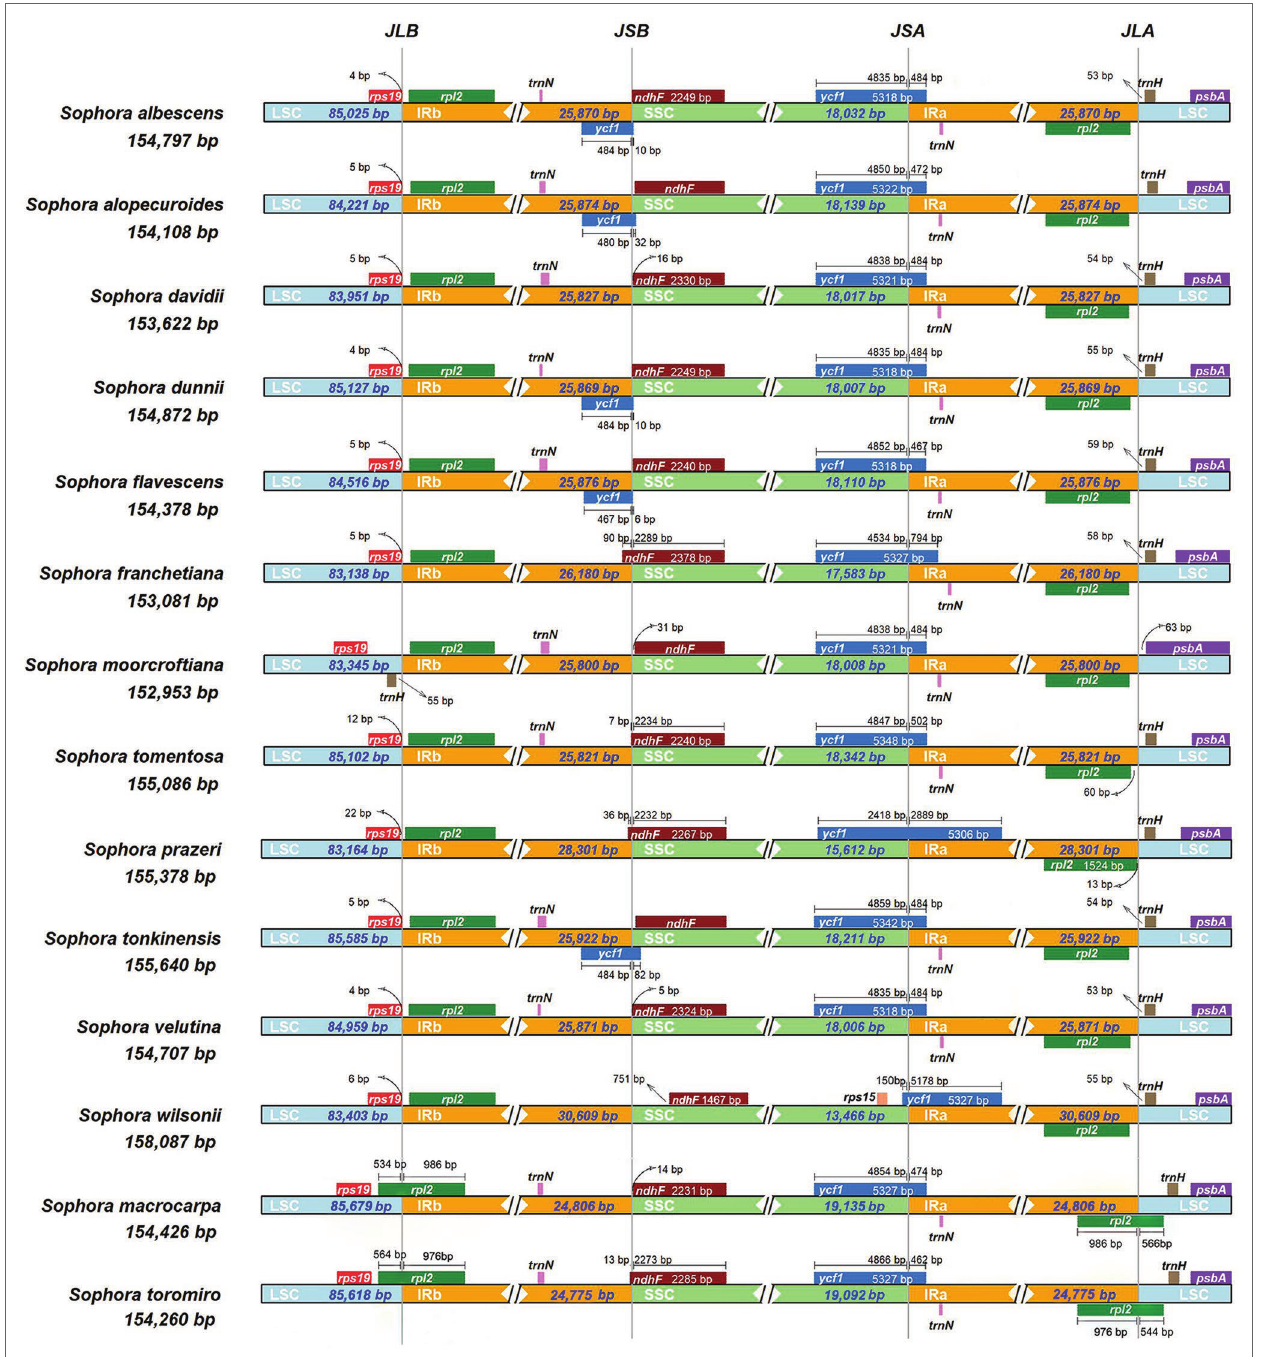
FIGURE 2 | Analyses of expansion and contraction of inverted repeats in the 14 Sophora plastid